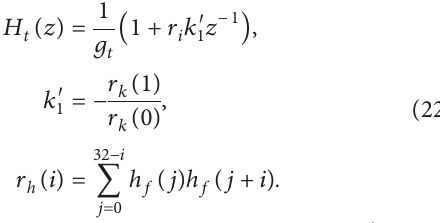
12.8 kHz. We set L 4, M 5, that is, 4/5 down- (cid:29) (cid:29) sampling, and after conversion, the sampling rate is 12.8 kHz,thatis,eachframeofspeechfrom320sample points to 256 sample points. The normalized cutoff frequency o for h ( n ) is 0.2 n, the length is N 120, and (cid:29) the amplitude response is shown in Figure 8. 12.8 kHz. We set up L 8, M 5, that is, 8/5 (cid:29) (cid:29) upsampling, and the converted sampling rate is 12.8 kHz, that is, each frame of speech changes from 160 sample points to 256 sample points. The nor- malized cutoff frequency ω x of h ( n ) is 0 . 125 π , the length is N 256, and the amplitude-frequency re- (cid:29) sponse is shown in Figure 9. 16 kHz. The 4/5 upsampling is performed, and the converted sampling rate is 16 kHz, which means that each frame of speech changes from 256 sample points to 320 sample points. The amplitude response is shown in Figure 10, where L 5, M 4, h ( n ) (cid:29) (cid:29) normalized cutoff frequency ω x is 0 . 2 π , and the length is N-120.